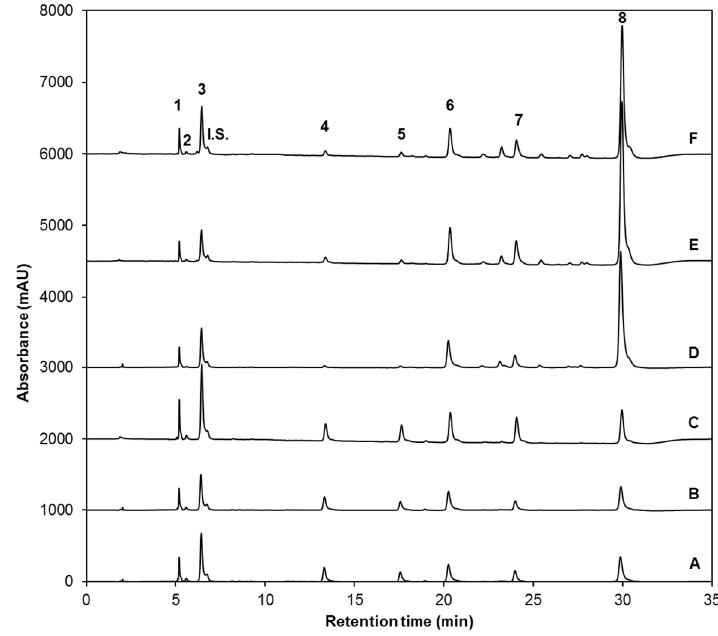
Figure 1. High-Performance Liquid Chromatography with Diode-Array Detection (HPLC-DAD) chromatograms (shown at 227 nm) of identified desulfoglucosinolates (dsg) from ethanol/water (70:30, v / v ) extracts of: ( A ) untreated control eight-day-old broccoli sprouts, broccoli sprouts treated with ( B ) UVA or ( C ) UVB radiation at the 7th day after sowing and harvested 24 h after the UV treatment, ( D ) 8-day-old broccoli sprouts treated with methyl jasmonate (25 µ M) every 12 h from